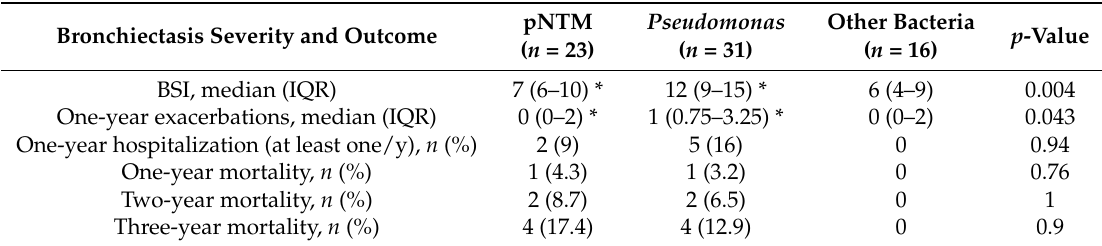
Table 3. Disease severity and outcomes according to the three study groups: pulmonary non-tuberculous mycobacteria disease (pNTM); chronic infection with P. aeruginosa ( Pseudomonas ) and chronic infection with bacteria other than P. aeruginosa (other